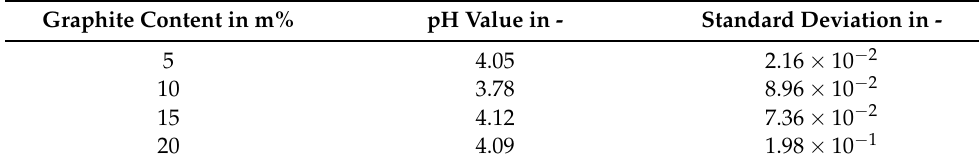
Table A9. PH values as a function of TX-100 content for a solution with no nanoparticles. Dispergator Content in m% pH Value in -